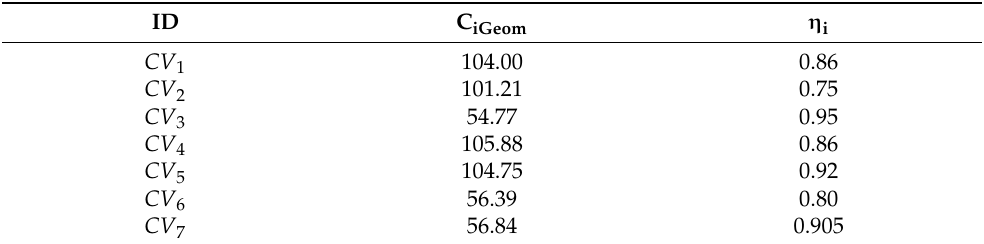
Table 4. Calibrated efficiencies for the set of conveyors in the crushing plant using Day 1 data.